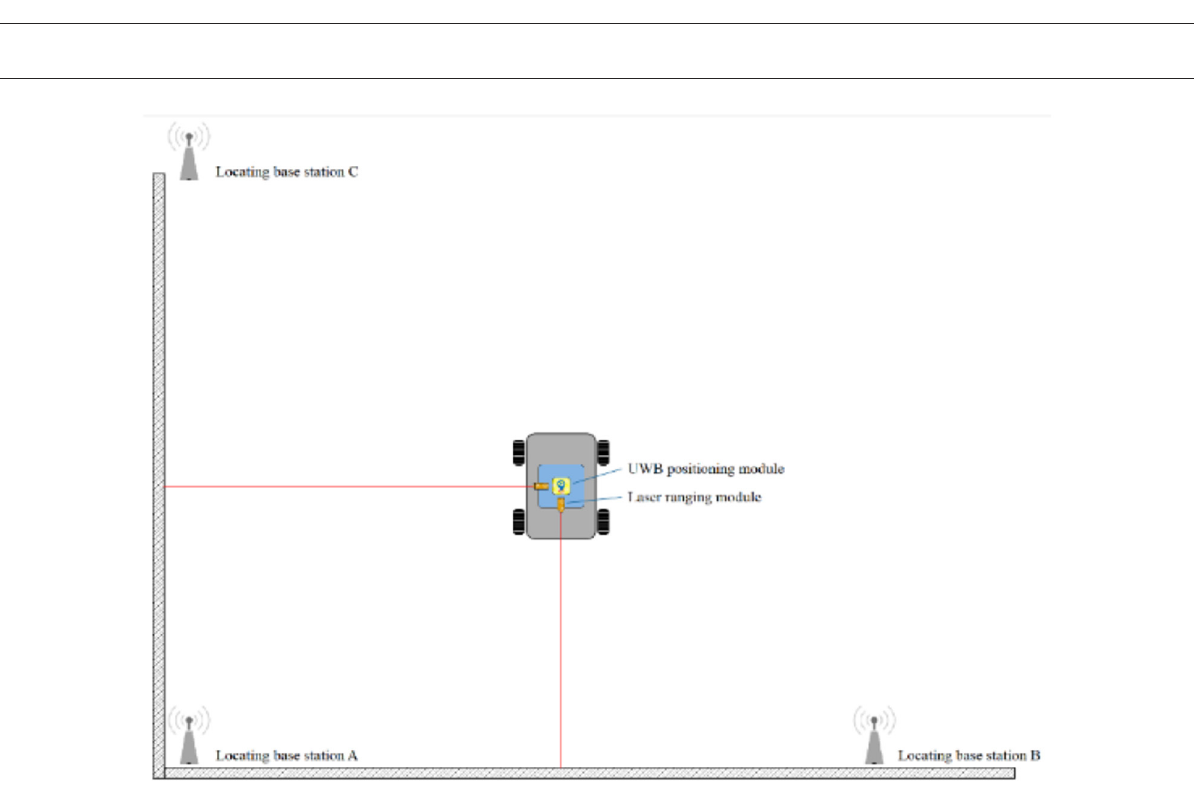
FIGURE11 A representation of the experimental